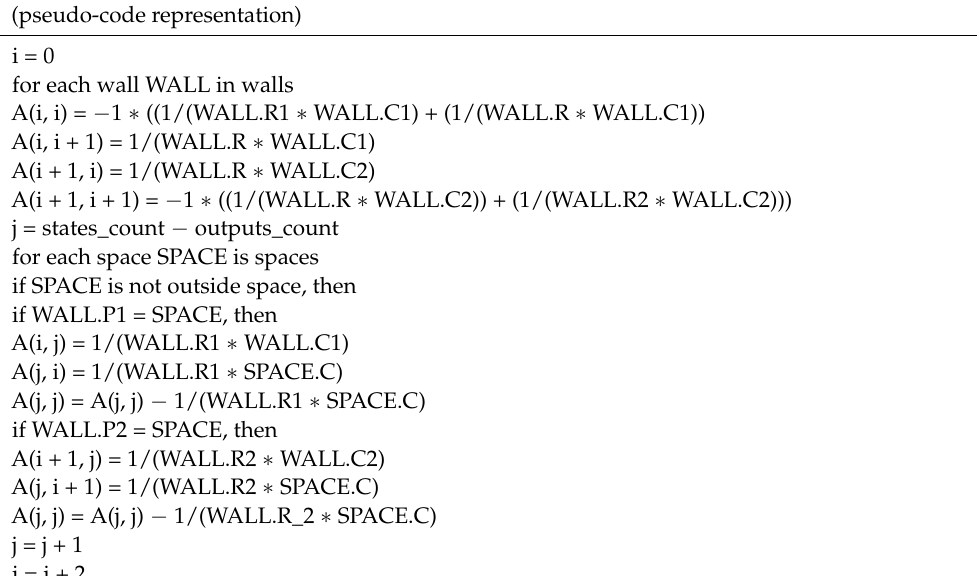
Algorithm 2. The definition of the structure of the state matrix A —walls and spaces (pseudo-code